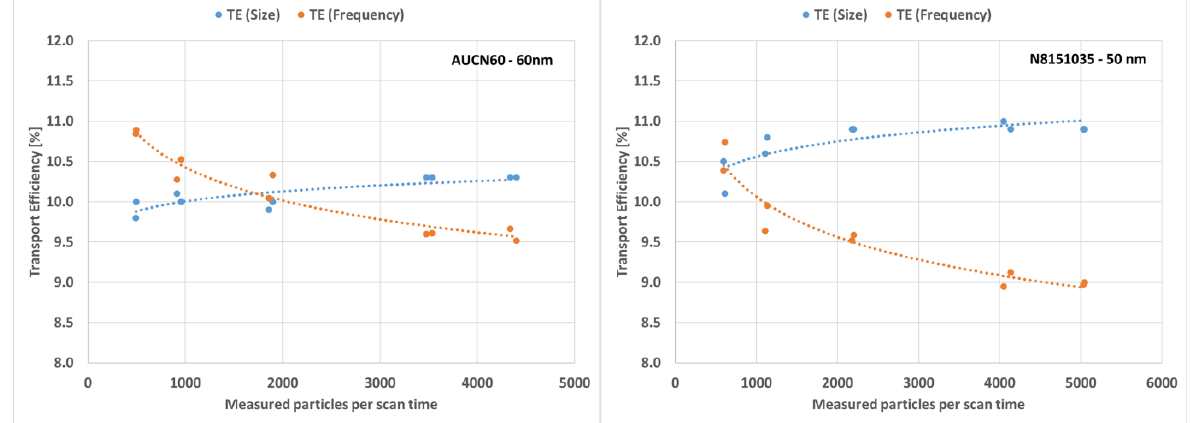
Figure 13. Impact of measured particles per scan time and calculated transport efficiencies based on frequency and size. By plotting the particle concentration in the aspirated suspension against the number of detected particles/scan time, which is nothing more than the definition of TEF, this ef- fect becomes less evident (Figure 14).